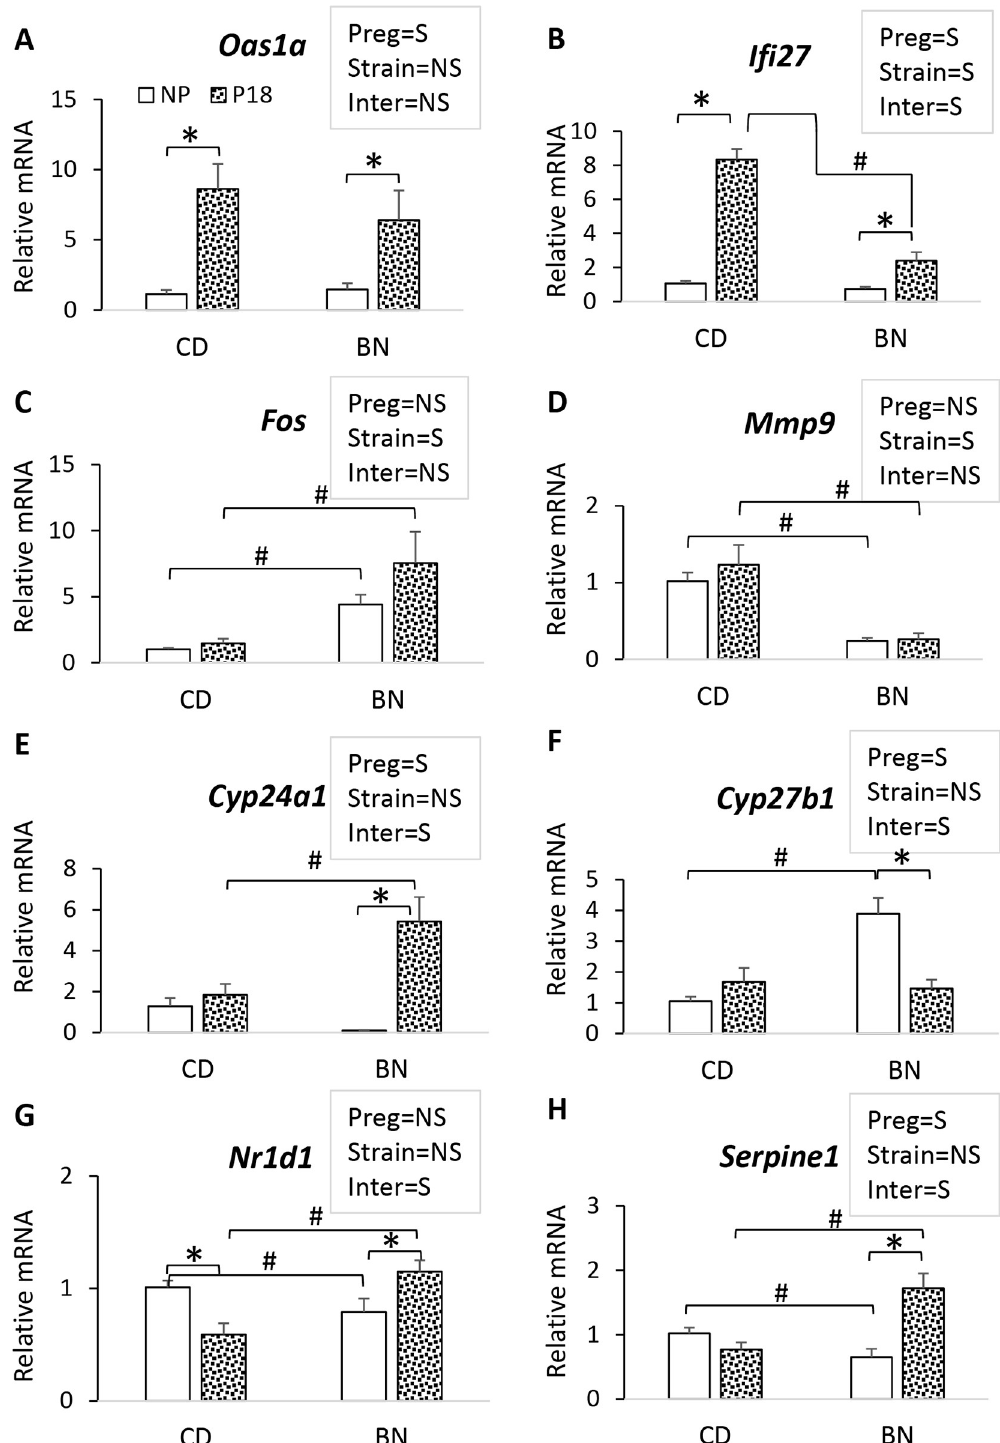
Fig 6. Validation of RNA-sequencing data. Quantitative SYBR green PCR was used to study 8 genes selected to validate DEGs from all four comparisons (BN_P/BN_NP, CD_P/CD_NP, BN_NP/CD_NP, and BN_P/CD_P). Two genes were selected on the basis of pregnancy regulation: A) Oas1a , and B) Ifi27 . Two genes were selected based on rat strain differences, C) Fos , D) Mmp9 , and 4 genes on differential regulation by pregnancy according to rat strain: E) Cyp24a1 , F) Cyp27b1 , G) Nr1d1 , and H) Serpine1 . mRNA levels are shown as fold of CD NP values. Bars represent the average ± error, n = 5 rats/